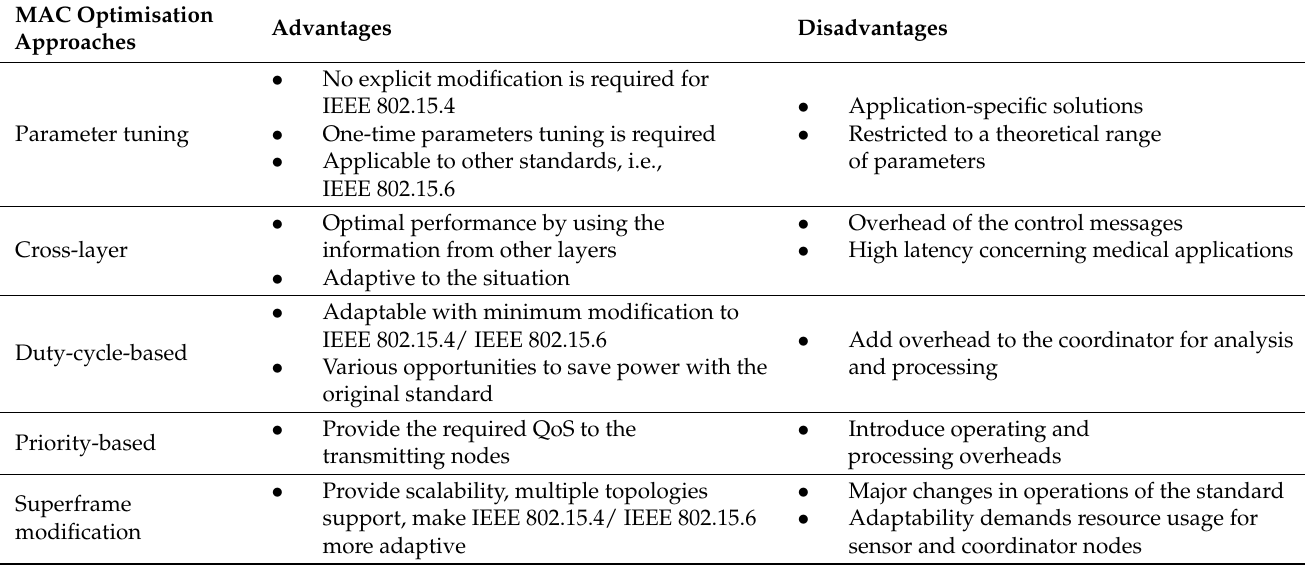
Table 7. Comparative analysis of optimisation approaches.